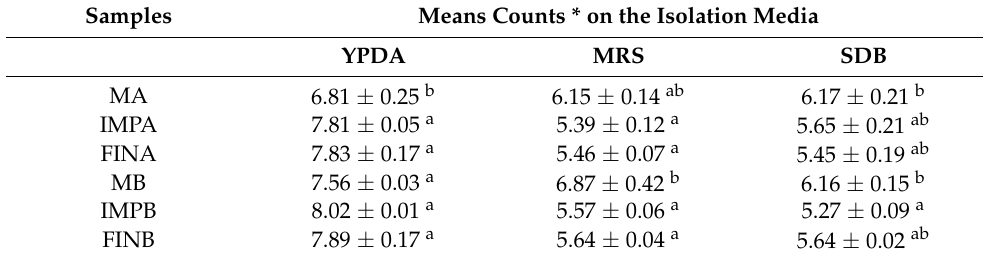
Table 2. Colony counts on the growth media used for the isolation of yeasts and lactic acid bacteria from dough